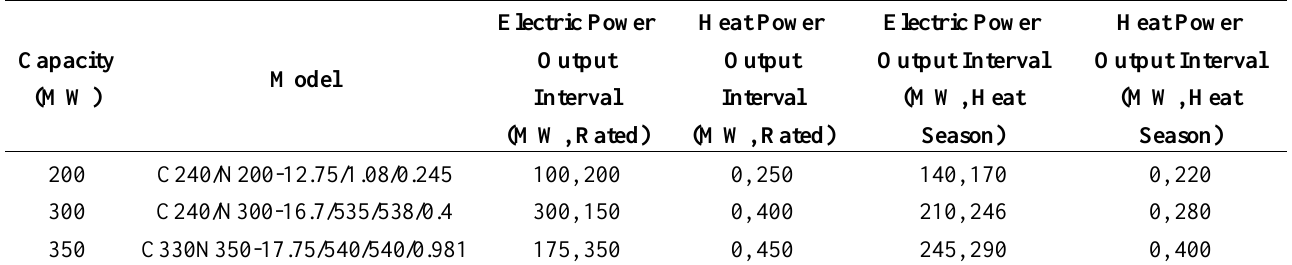
Table 4. The parameters of the combined heat and electric power (CHPs) within the simulation